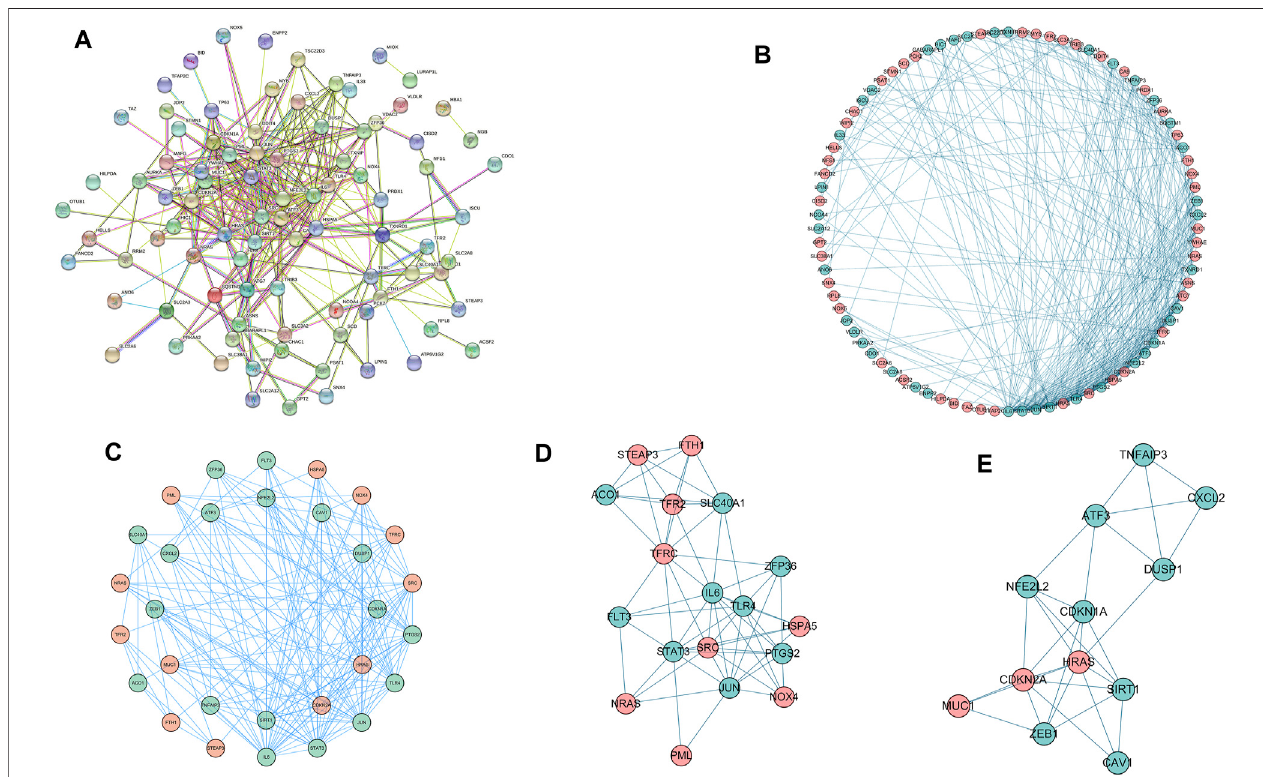
FIGURE 3 | Differentially expressed ferroptosis-related genes were used to construct protein-protein interaction networks and subnetworks. (A) PPI interaction network map obtained from the STRING database. (B) Genes of the interacting PPI network visualized by Cytoscape. Red nodes represent upregulated genes, while blue nodes represent downregulated genes. (C) Two most signi fi cant MCODE modules visualization. (D,E) Two most signi fi cant MCODE components form the PPI network.